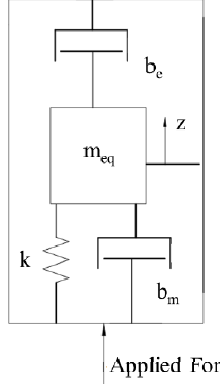
Figure 7. Mechanical model for electromagnetic energy harvester